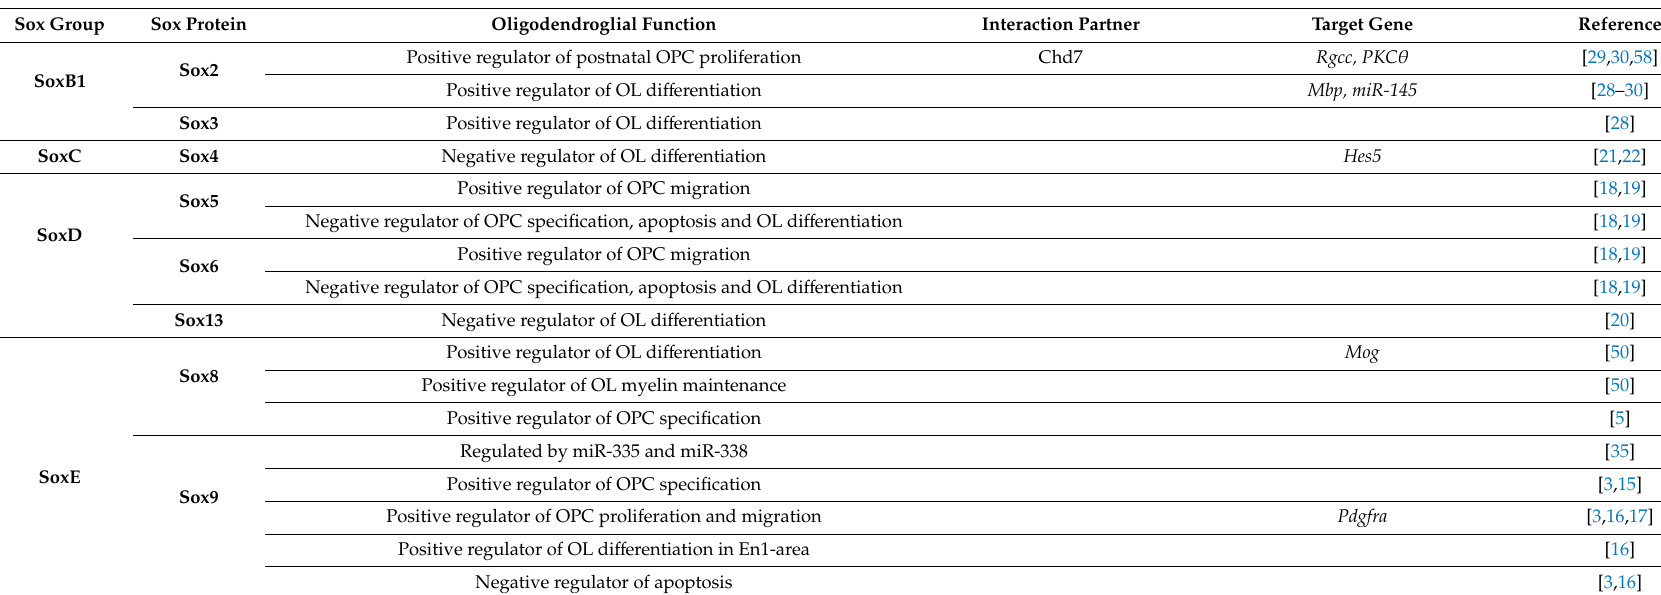
Table 1. Summary of oligodendroglial Sox protein functions described in this review. Sox proteins are ordered according to corresponding Sox groups and reported protein functions are listed together with known interaction partners as well as target